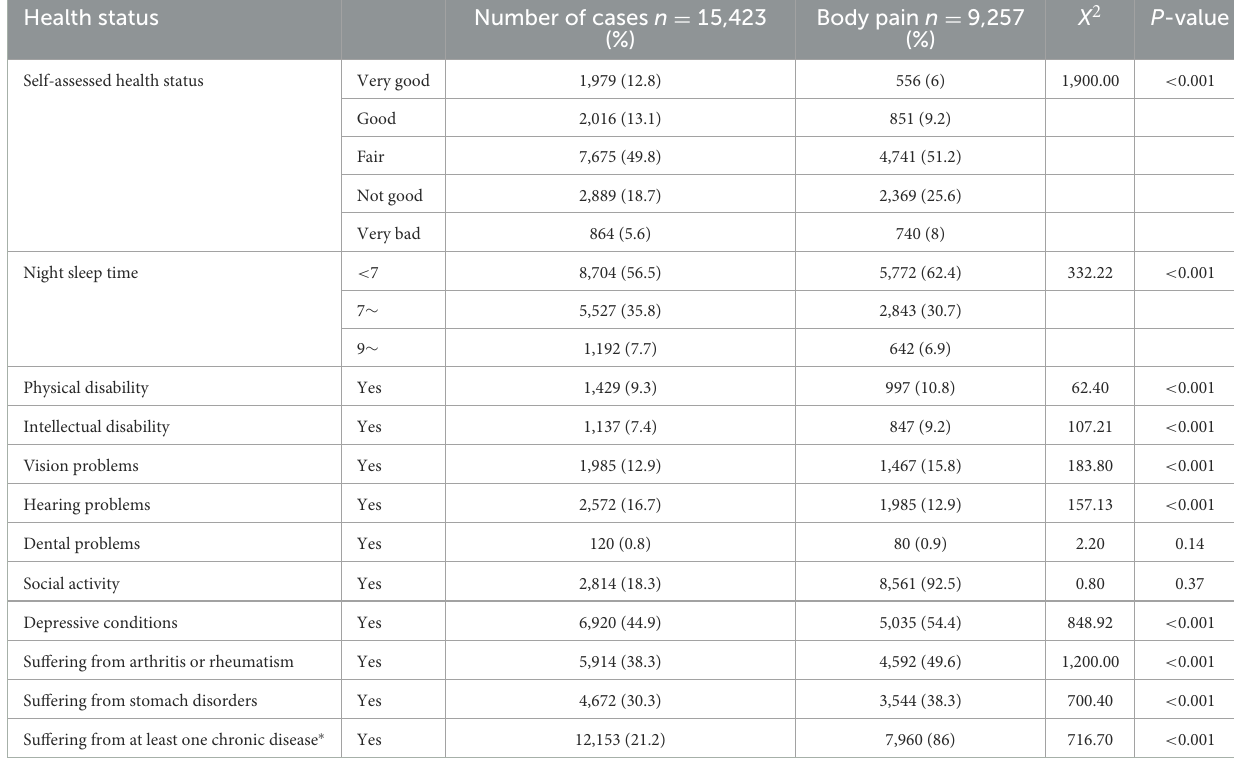
TABLE 2 The relationship between physical pain and health status in middle-aged and older adults.